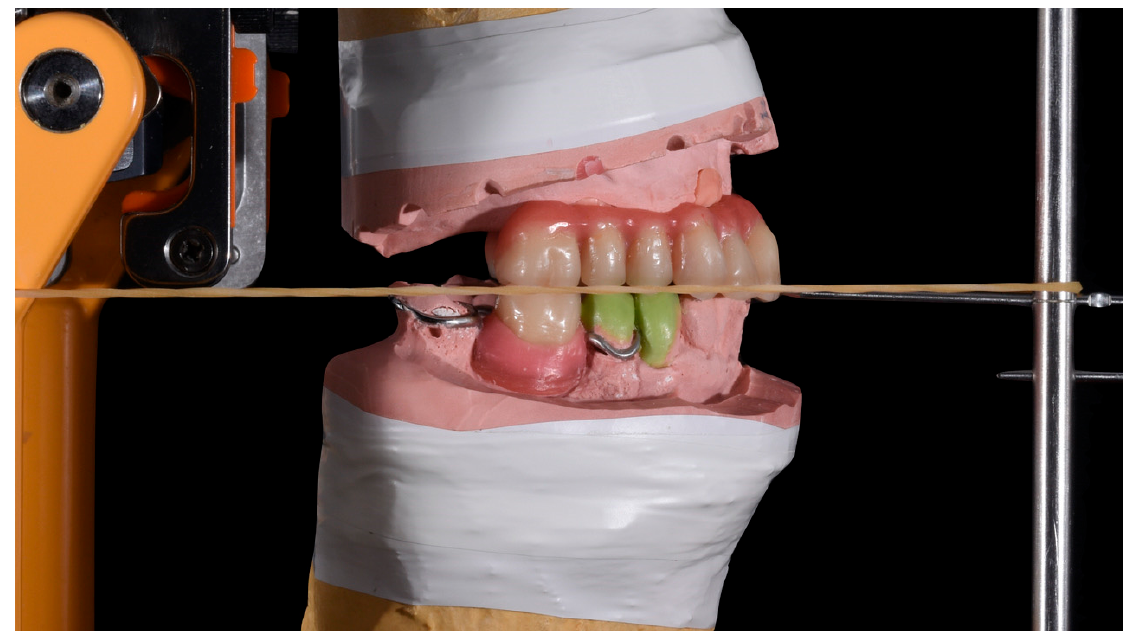
Figure 14. The correct occlusal plane.